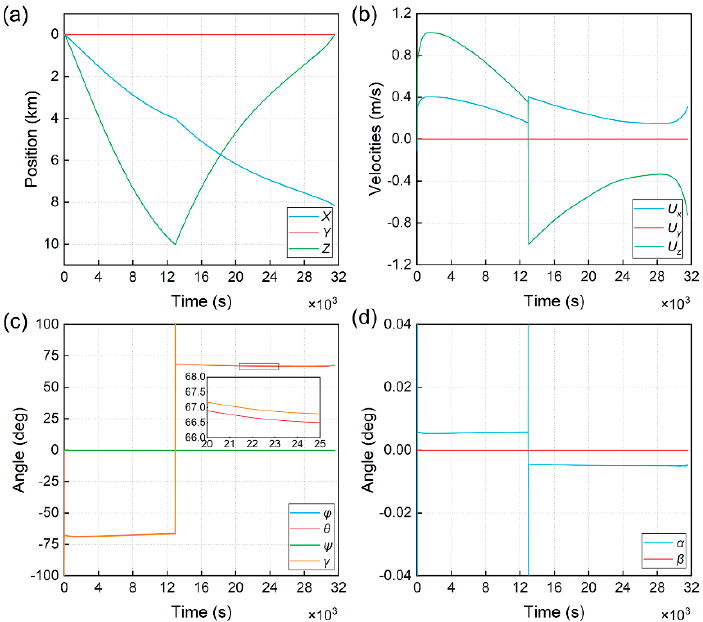
Figure 9. Simulation results in VM mode: ( a ) Position; ( b ) Velocities; ( c ) Euler angles and gliding angles; ( d ) Attack angle and side slip angle.